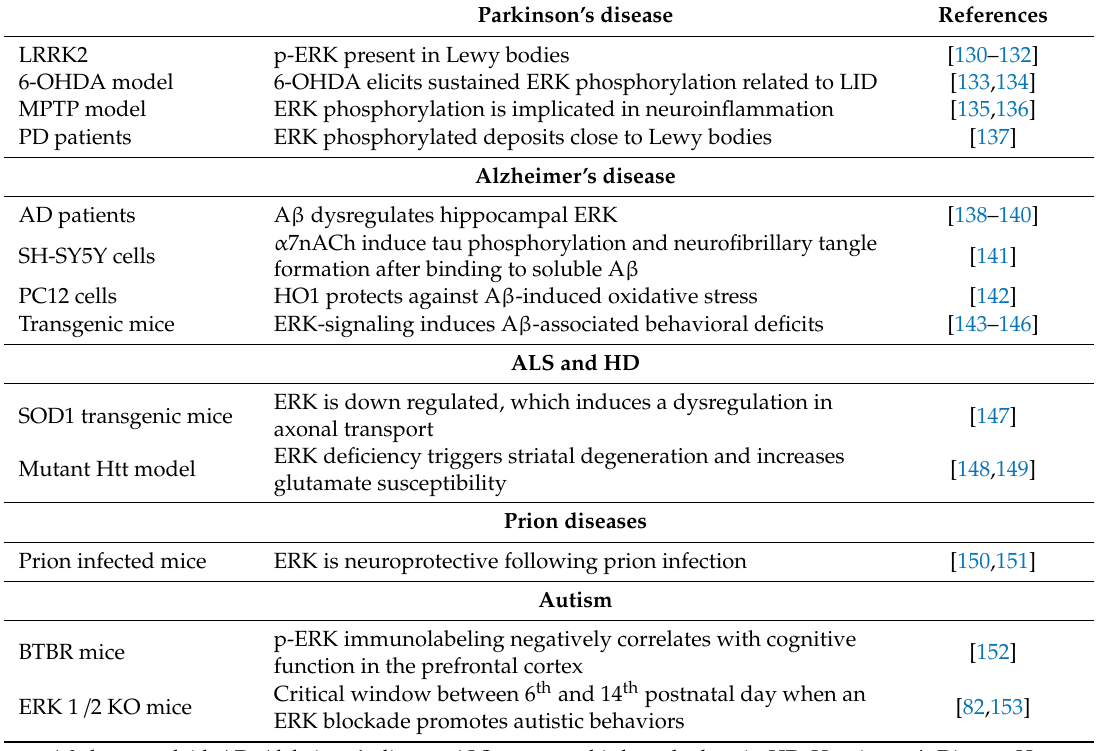
Table 3. Participation of Erk in neural and neurodegenerative diseases. Parkinson’s